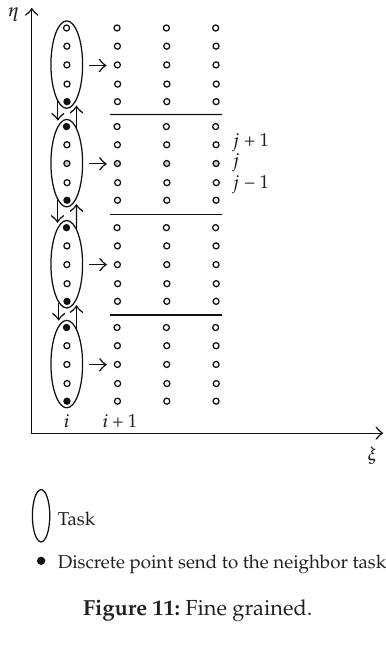
Figure 11: Fine grained.